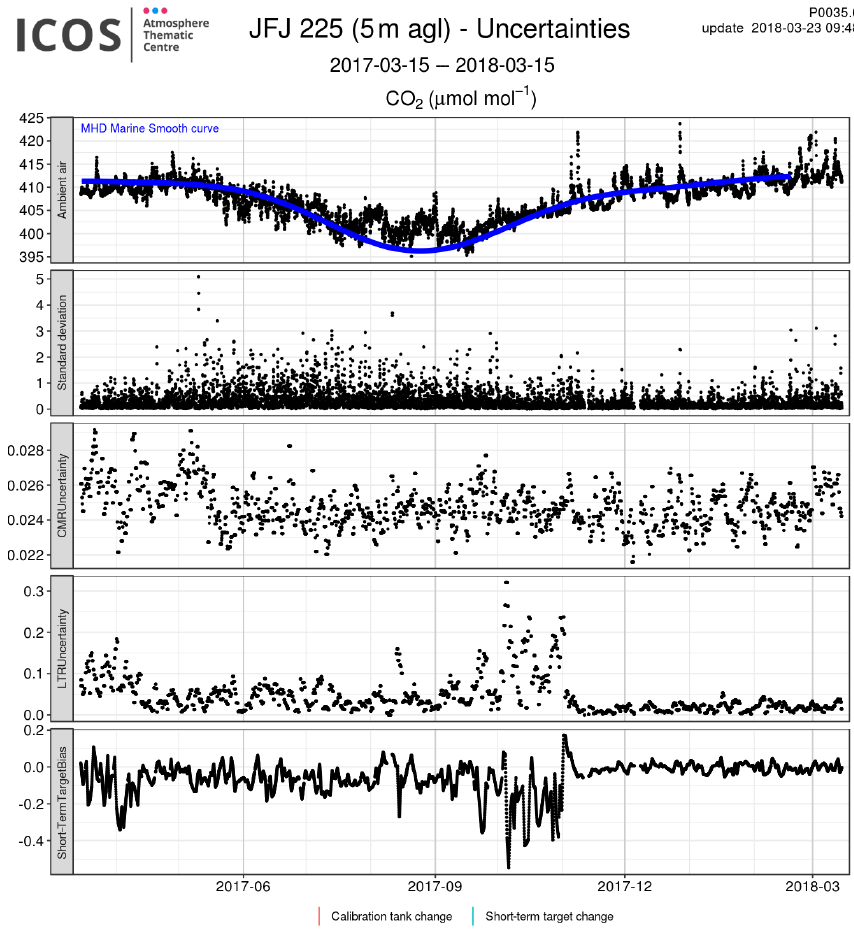
Figure 12. Last year of greenhouse gas measurements along with estimated uncertainties at Jungfraujoch station (JFJ) for instrument 225. Continuous measurement repeatability (CMR) and long-term repeatability (LTR) are calculated as in Yver Kwok et al. (2015). The short-term target bias is calculated as the difference between the hourly average of the short-term target injections and the value assigned by the FCL- CAL. In the top panel, the ambient air data are compared to the MHD (Mace Head, Ireland) marine smooth curve, derived from atmospheric measurements made at Mace Head, a historical European background site. The smooth curve is calculated using NOAA’s CCGCRV